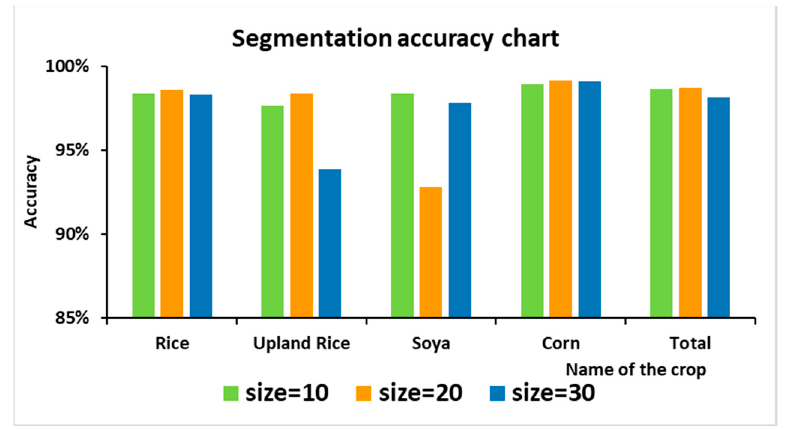
Figure 10. Classification accuracy statistics under different “sizes”.